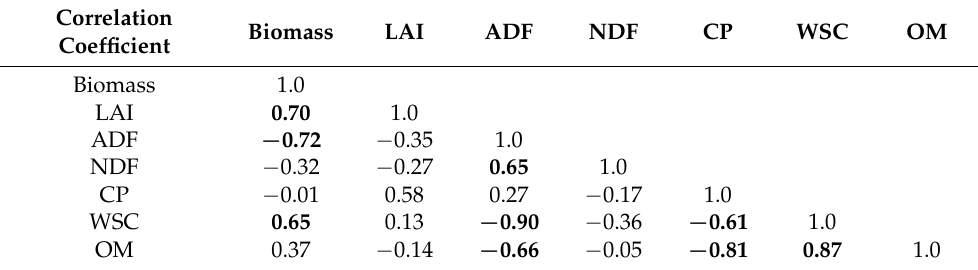
Table 3. Pearson correlation coefficient ( r ) among all pairs of laboratory-derived pasture quantity and quality parameters (39 samples for each parameter). The largest correlations ( r > ± 0.6) have been highlighted in bold.